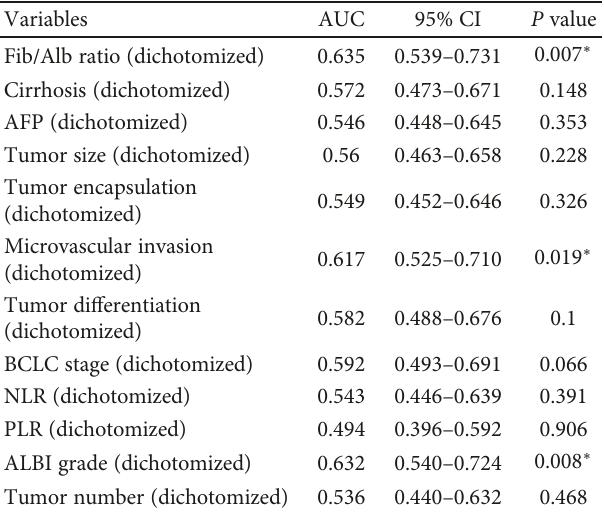
Figure 2: Comparison of the areas under the curves for the Fib/Alb ratio, NLR, PLR, ALBI grade, and other clinical indexes. The discrimination ability of the Fib/Alb ratio, NLR, PLR, ALBI grade, and other clinical indexes was compared by the AUC for OS. Table 4: Comparison of the areas under the curves for Fib/Alb ratio, NLR, PLR, ALBI grade, and other clinical